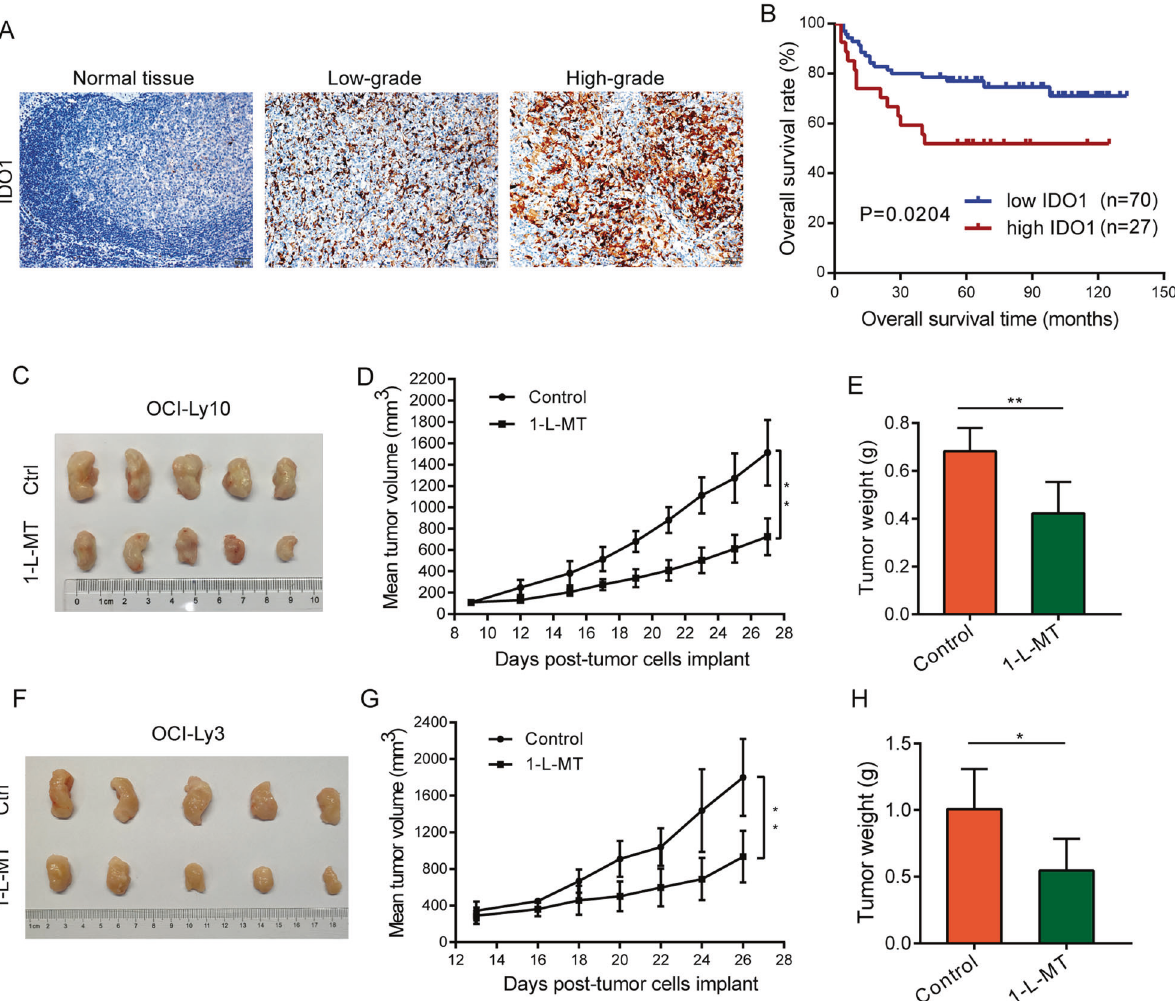
Fig. 2 High IDO1 expression predicted poor outcome, and IDO1 inhibition suppressed tumorigenesis in NOD/SCID mice. A Representative IHC images of IDO1 in normal tissue and 97 DLBCL patient samples (× 200, scale bar, 50 μ m). B Kaplan-Meier OS analysis of DLBCL patients with high IDO1 expression and low IDO1 expression levels ( P = 0.0204, n = 97). C and F A total of 5×10 6 OCI-Ly10 ( C ) or OCI-Ly3 ( F ) cells were subcutaneously injected into the posterior fl ank of NOD/SCID mice. Representative images of xenograft tumors treated with or without 1-L- MT are presented. D and G Tumor volume of OCI-Ly10 ( D ) or OCI-Ly3 ( G ) tumor-bearing mice demonstrated that the 1-L-MT-treated group presented a smaller size than the control group. E and H 1-L-MT-treated OCI-Ly10 ( E ) or OCI-Ly3 ( H ) tumor-bearing mice formed tumors with lower weights compared to the control group. Statistical analysis was analyzed with a two-sided student ’ s t-test. * P < 0.05 and ** P <